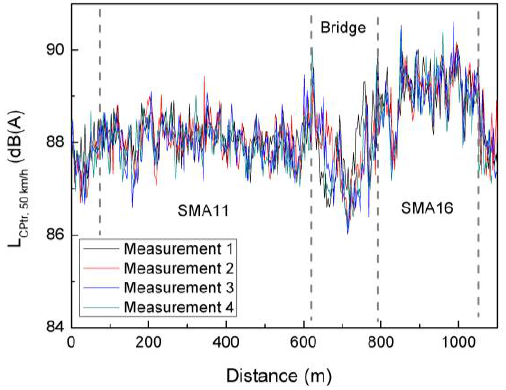
Figure 7. Repeatability of the tire pavement sound levels ( L CPtr, 50km/h ) measured in the bituminous mixtures SMA11 and SMA16.